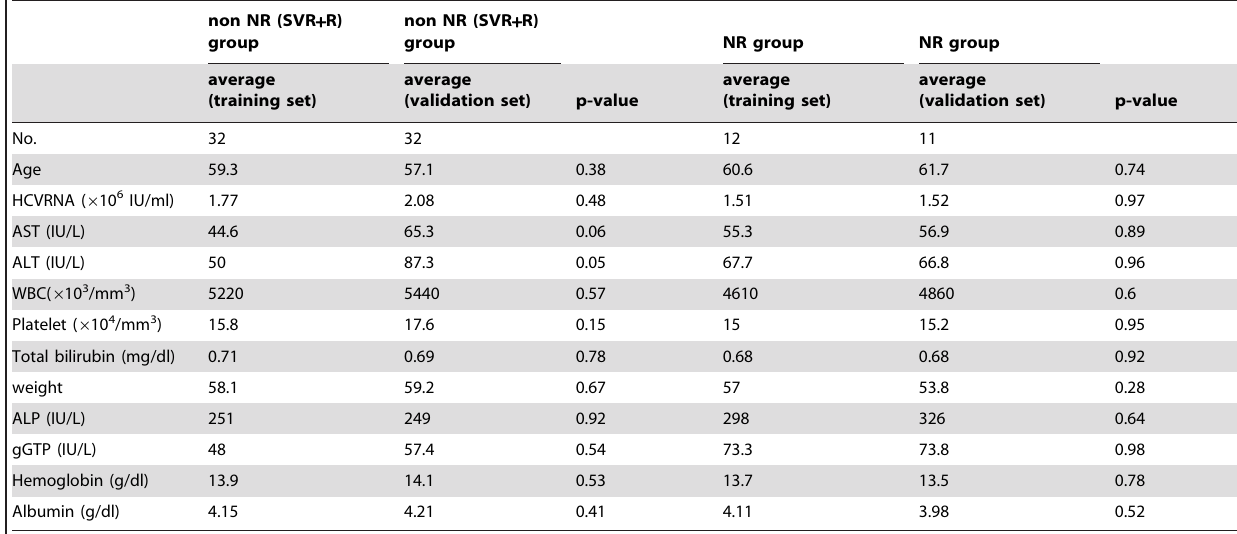
Table 4. Characteristics of the training and validation set.